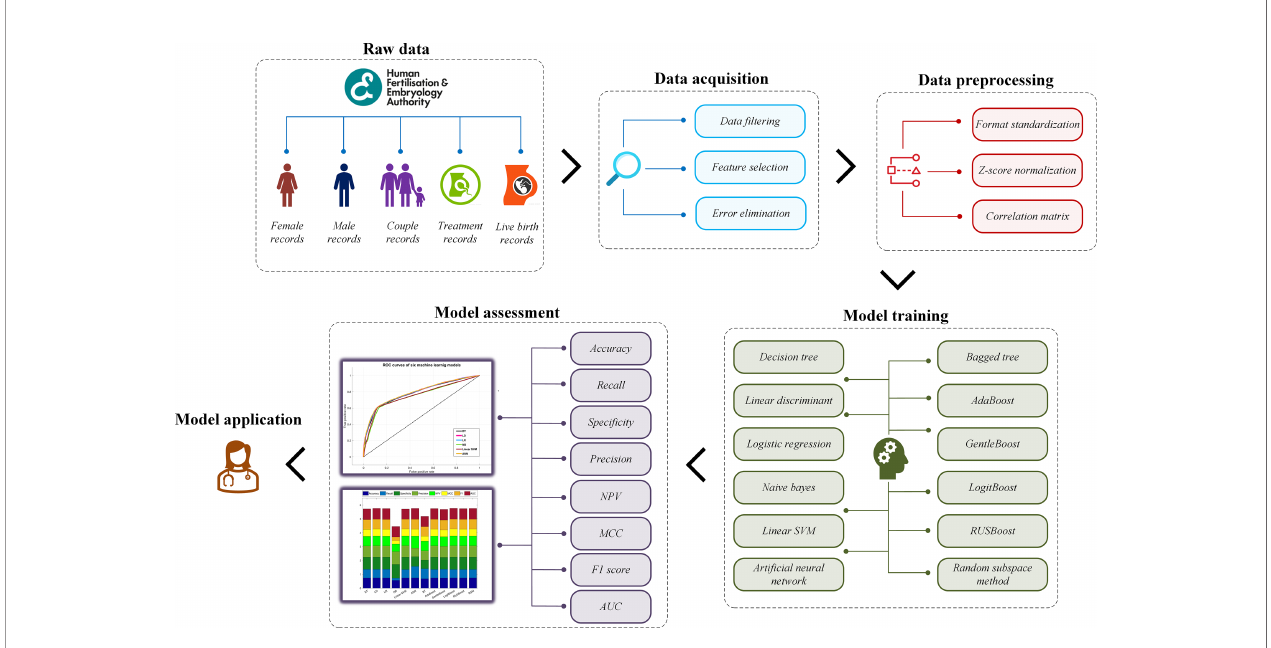
FIGURE 1 | The overall model building